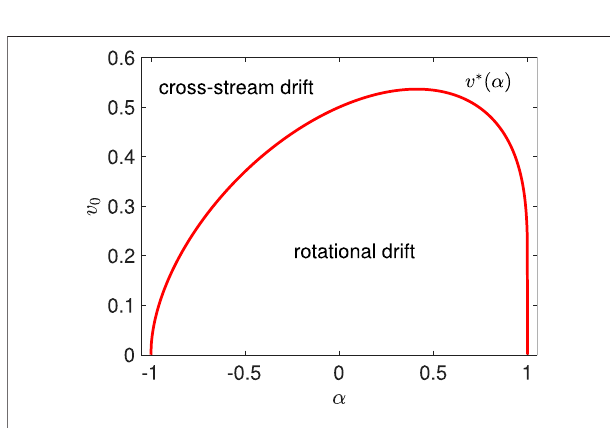
FIGURE 3 | Swimmer phase space structure as a function of the swimming speed v 0 and shape parameter α , where α (cid:1) 0 corresponds to circularparticles.Theredcurveis v *( α )( Eq.9 ),thesetofparameterswherethe saddles are heteroclinically connected and phase space bifurcates from containing rotational drift trajectories to cross-stream drift